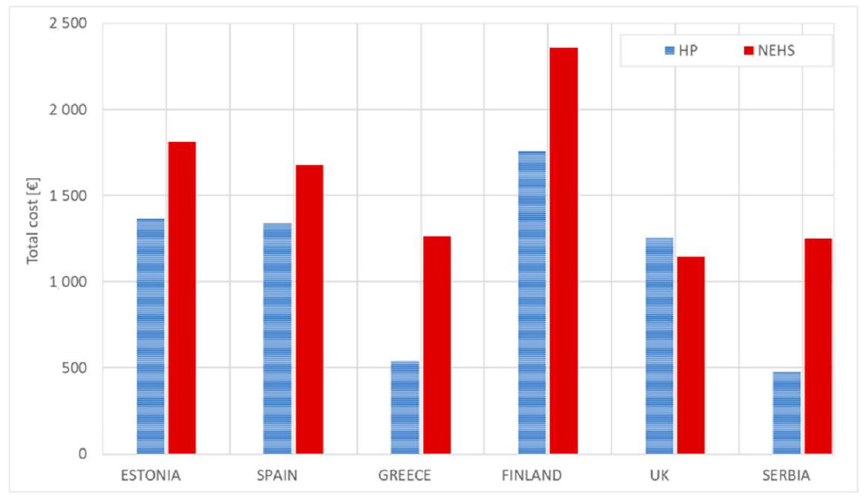
Figure 4. Total costs to cover the energy demand in each country per technology throughout the heating season.